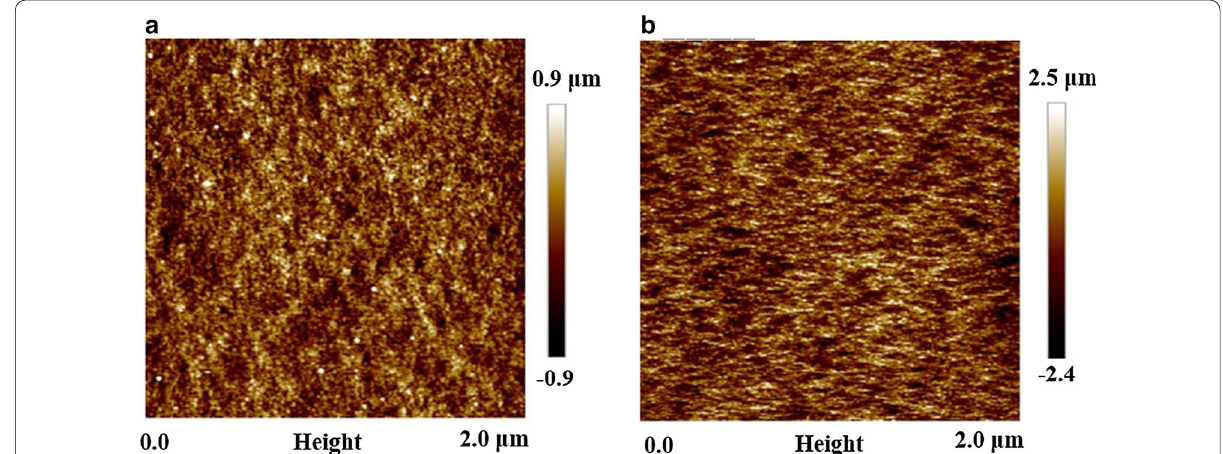
Fig. 4 AFM images of a unetched GaAs sample; b black GaAs